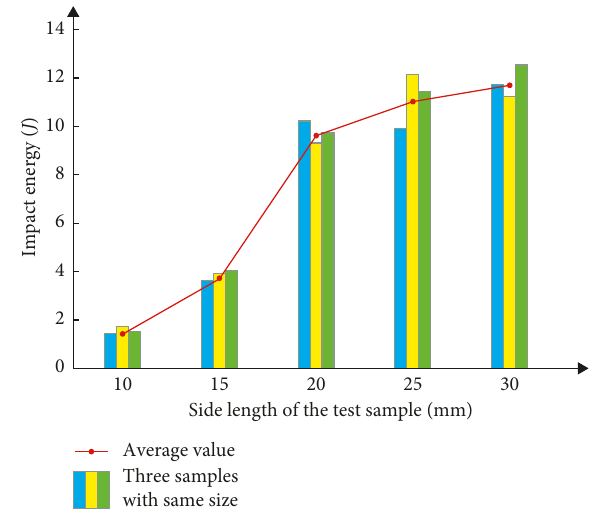
Figure 10: The impact energy for the sample in each group and the average